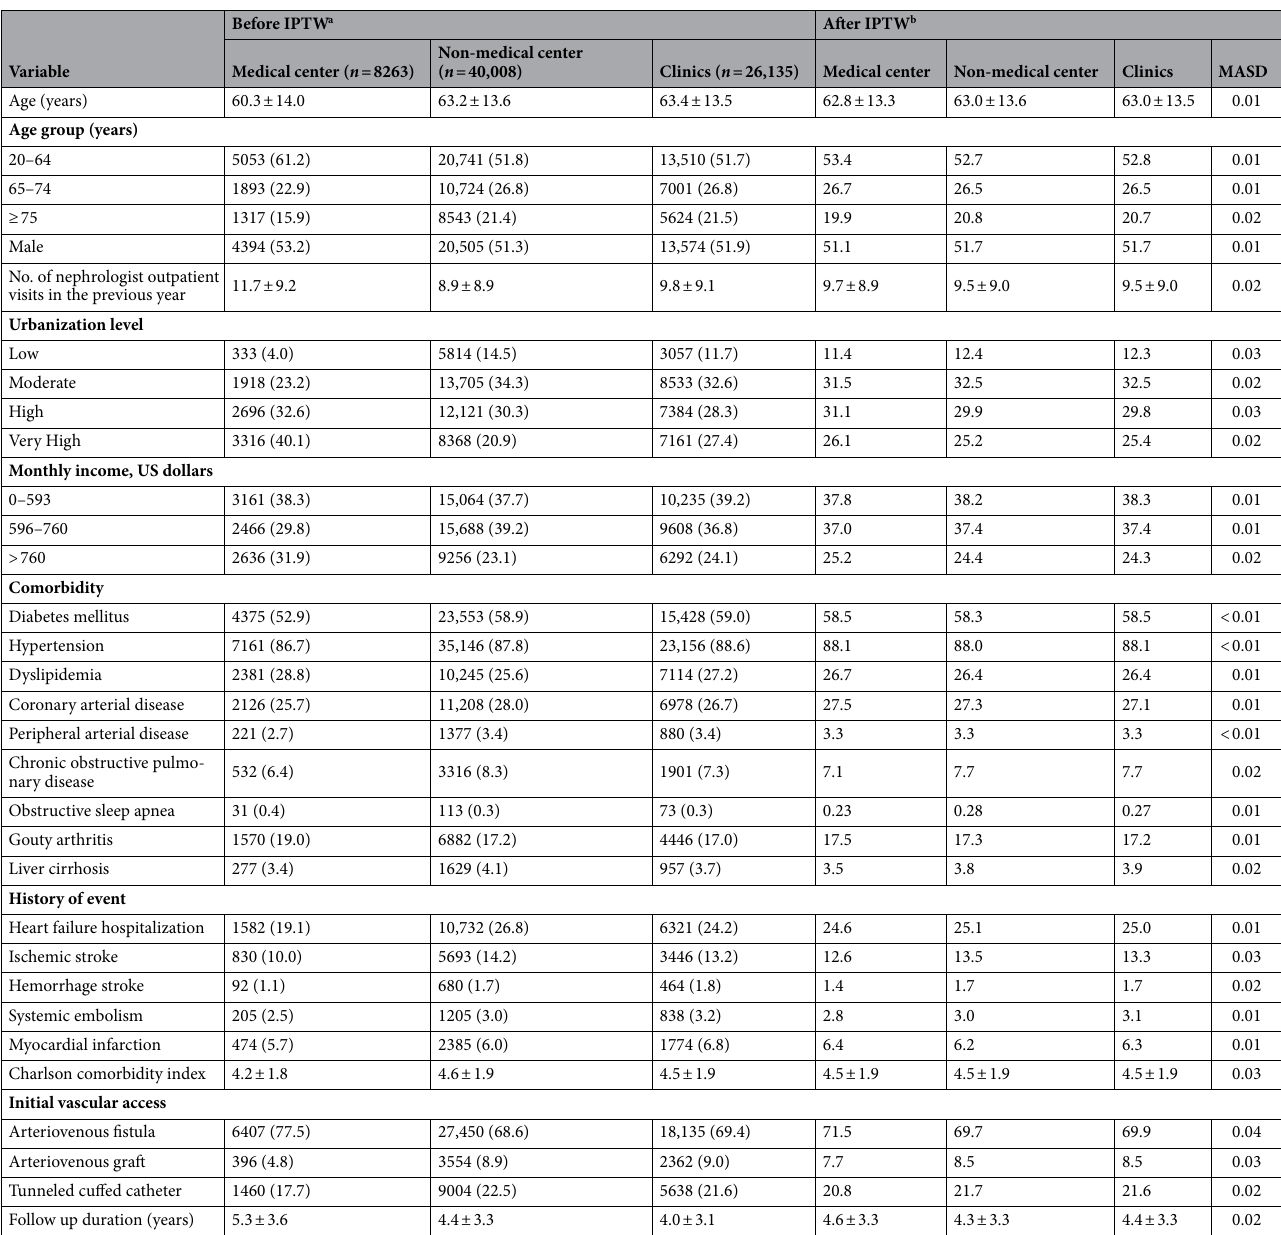
Table 1. Baseline characteristics of patients according to the dialysis facility level before and after IPTW. IPTW inverse probability of treatment weighting, MASD maximum absolute standardized difference, AV arteriovenous. a Data were presented as frequency (percentage) or mean ± standard deviation; b Data were presented as percentage or mean ± standard